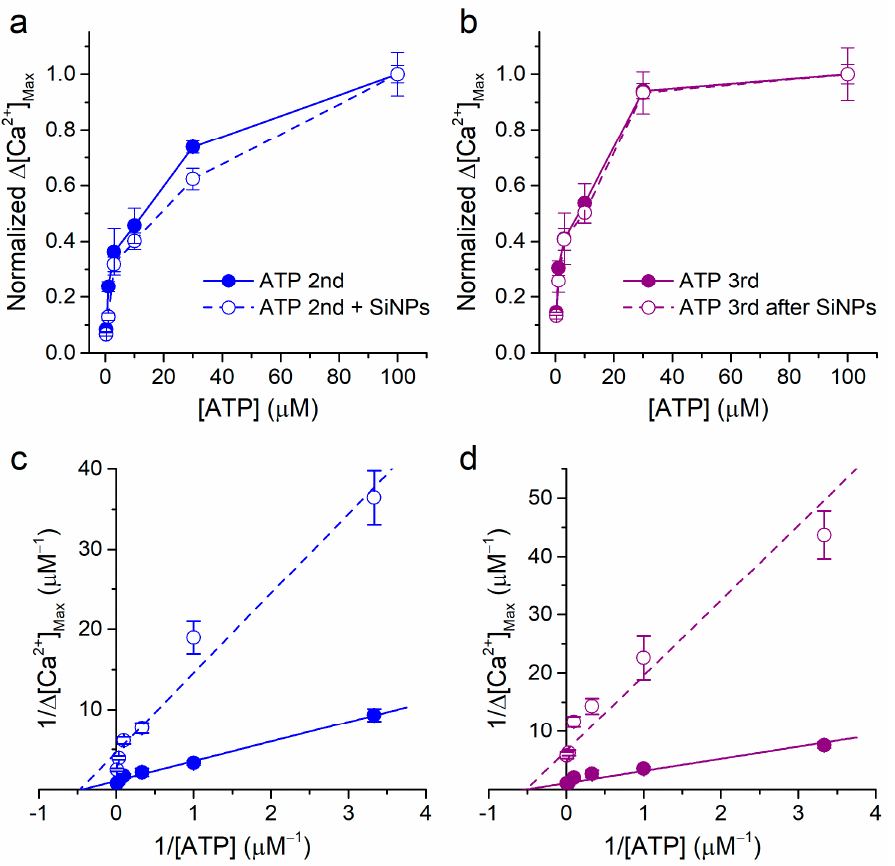
Figure 8. Non-competitive inhibitory effect of SiNPs on the response to ATP. ( a , b ) Normalized concentration dependence of the amplitude of the responses to ATP, for the 2nd application (control and in the presence of SiNPs) and for the 3rd application (control and after washout of SiNPs). The normalization was performed by dividing the data sets of Figures 1d and 5d by the corresponding values obtained for 100 μ M ATP. ( c , d ) Lineweaver–Burk plots of the data shown in Figures 1d and 5d. The lines represent fits with linear functions. The data are represented as mean ± s.e.m. The n numbers are the same as in the original figures.